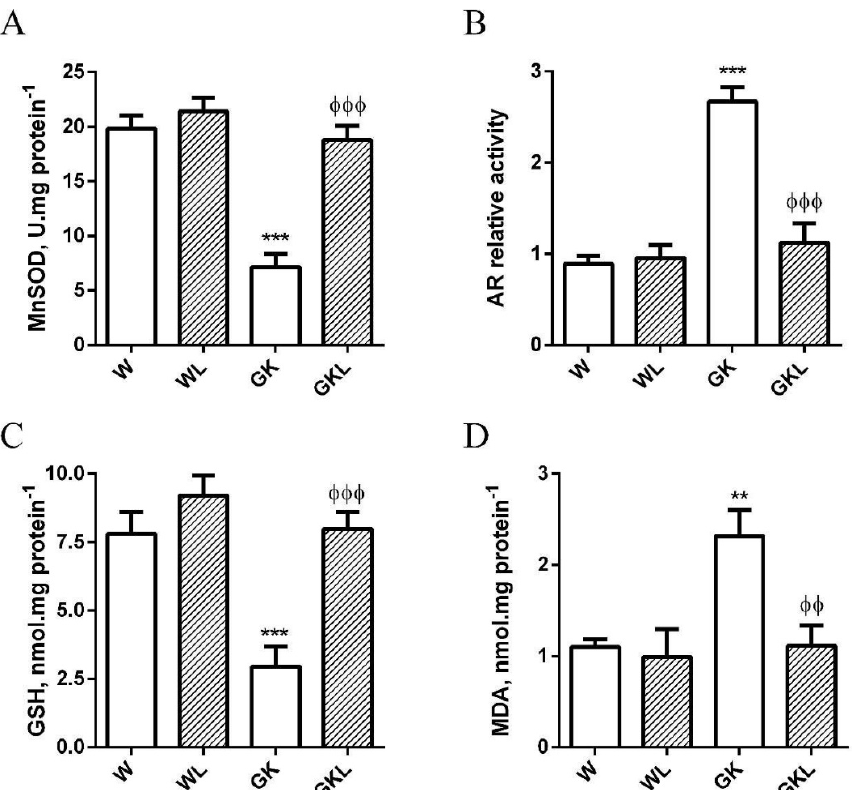
Figure 5. Effects of luteolin treatment on reduced antioxidant defenses and increased lipid peroxidation in perivascular adipose tissue (PVAT) of thoracic aorta from diabetic Goto-Kakizaki (GK) rats. Activities of manganese superoxide dismutase (MnSOD; A ) and aldose reductase (AR; B ), tissue contents of glutathione (GSH; C ), and malonaldehyde levels (MDA; D ) in PVAT of thoracic aortas of GK rats compared with nondiabetic Wistar (W) rats treated with (WL, GKL) or without luteolin. Data are expressed as mean ± SE ( n = 10). *** p < 0.001 vs. W group; ϕϕϕ p < 0.001 vs. GK group; ** p < 0.01 vs. W group; ϕϕ p < 0.01, vs. GK group.